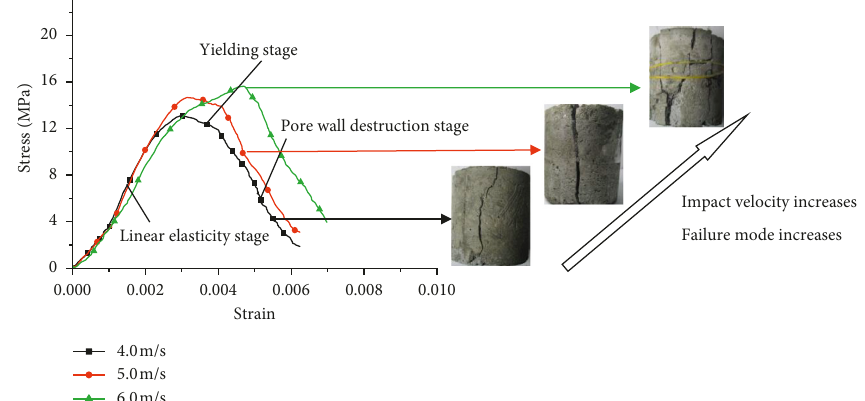
Figure 11: Foam concrete with fly ash stress-strain curve at 1,000kg/m 3 .